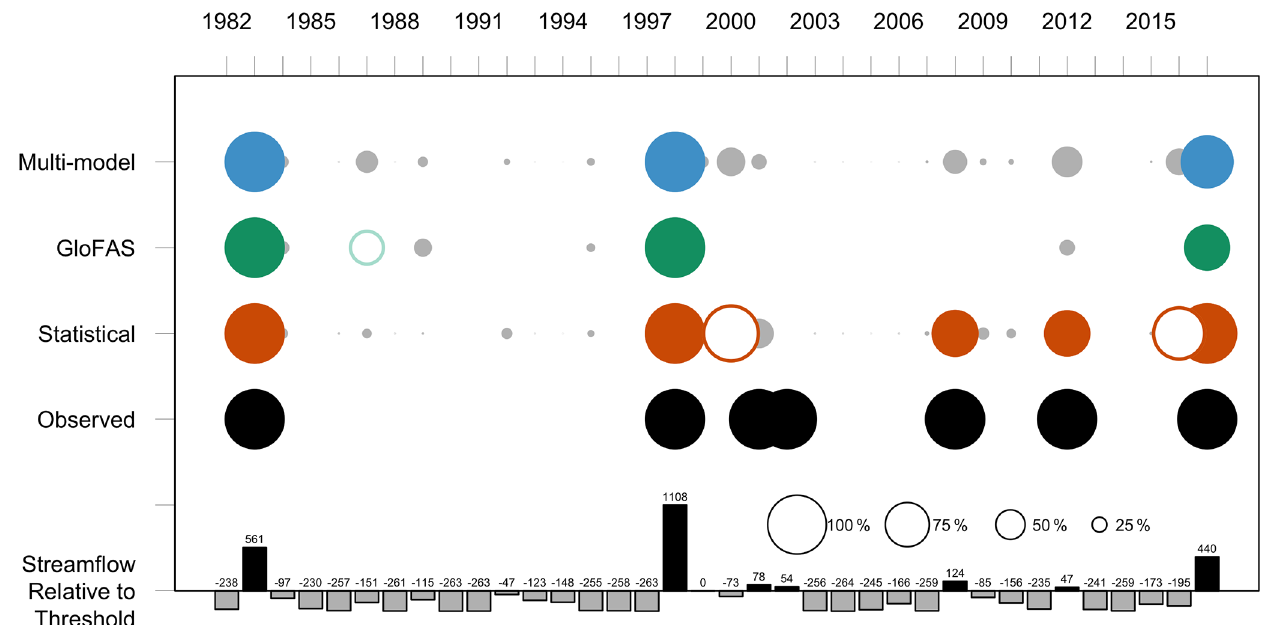
Figure 7. Same as Fig. 6 for Piura River at Puente Sánchez